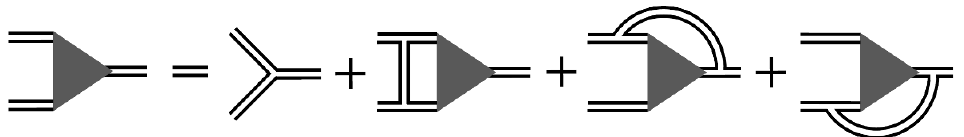
Figure 17 . Integral equation for the e(cid:11)ective vertex characteristic of the collinear splittings. The hard and soft momenta are not